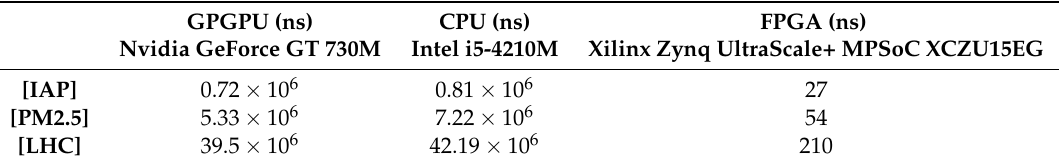
Table 9. Inference times for a single sample on various devices. The general-purpose graphics processing unit (GPGPU) and central processing unit (CPU) experiments were done with uncompressed models, since unstructured pruning and quantization does not significantly affect the performance. For FPGA, the best per-model pruning and quantization results were